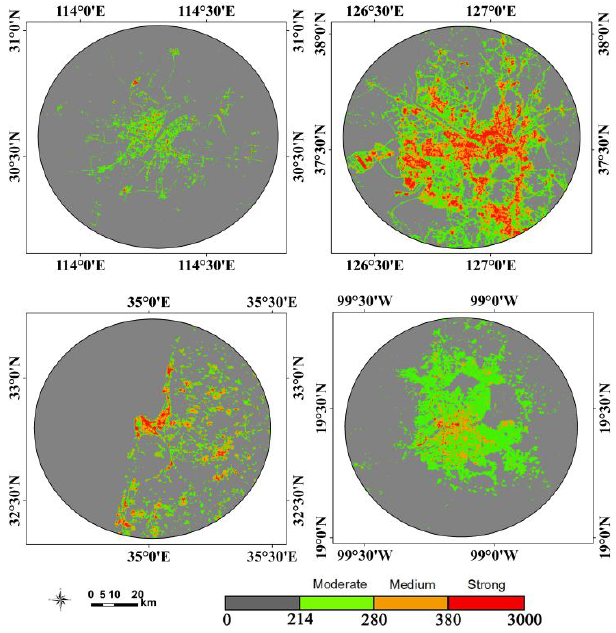
Figure 10. Urban light pollution patterns: ( a ) refers to Wuhan; ( b ) refers to Seoul; ( c ) refers to Haifa; ( d ) refers to Mexico City. Sensors 2018 , 18 , x